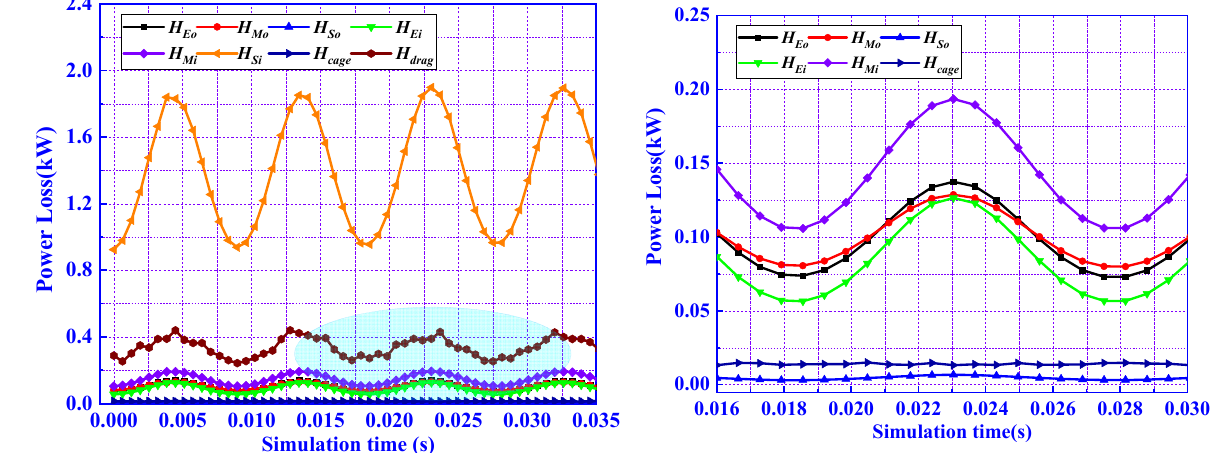
Figure 13. Power loss in the time domain. Because of the design constraints of ball bearings, the structure and dimensions of the cage and ball cannot be greatly changed, which has little effect on the H cage , H c and H drag at constant load and speed. So, the major structural parameters, such as outer raceway diameter D e , inner raceway diameter d i , raceway curvature radius f i and f o , etc. are selected as the influencing factors of the power loss in the contact areas of the balls-inner ring and balls-outer ring here. Moreover, in order to explain how the major structural parameters affect the power loss, the maximum value of Pv , the spinning sliding velocity v , the i ( o ) i ( o ) spinning angular velocity ω , the maximum contact stress P , the spin-roll ratio SR , i ( o ) i ( o ) i ( o ) the length of the elliptical contact area a and b , etc. must be set. It should be noted i ( o ) i ( o ) that the results below are based on the assumption that the contact interfaces between balls and raceways are in the stage of 440C-Ag coating. The analysis results of 440C-PTFE transfer film and 440C-440C show the same trend and will not be discussed here.